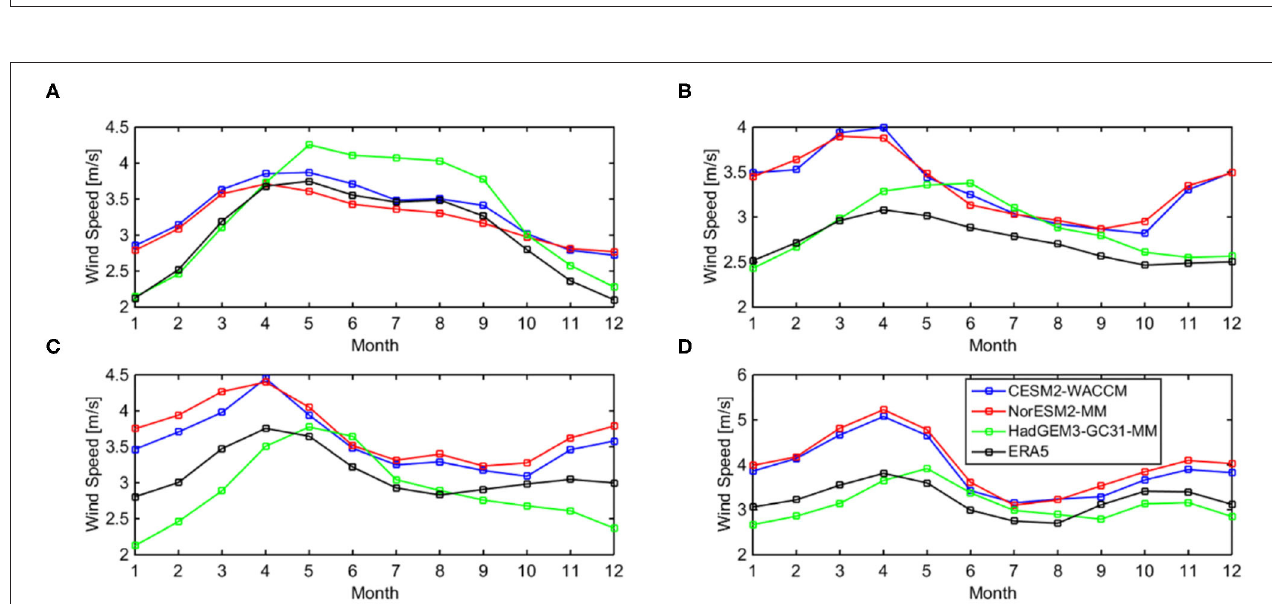
FIGURE 4 | Yearly mean 10-m wind speed (1986–2014) of CMIP6 and ERA5 (black line represents ERA5, and the blue, red, and green lines represent CESM2-WACCM, NorESM2-MM, and HadGEM3-GC31-MM, respectively). (A–D) Region I, region II, region III, and region IV, respectively.